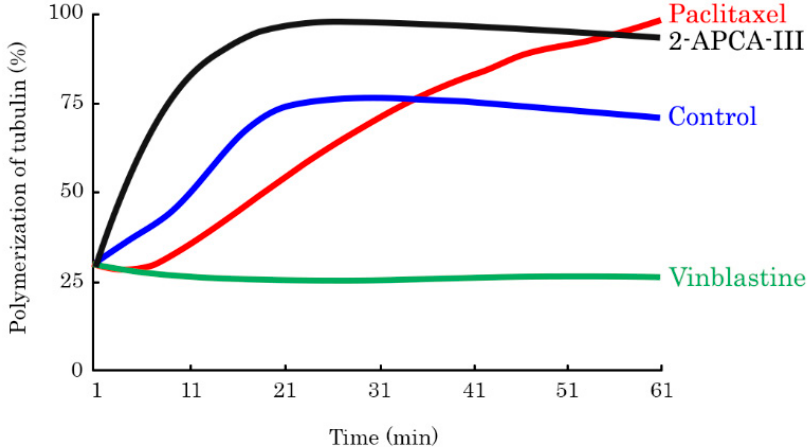
Figure 4. Dynamics of tubulin polymerization in samples treated with 2-APCA-III. Tubulin was also incubated with paclitaxel and vinblastine at 37 °C and absorbance was assessed every minute for 1 h. A shift of the curve to the upper left of the control (DMSO) represents an increase of the polymerized microtubule. A shift to the down right reflects the decrease in the rate of tubulin polymerization.